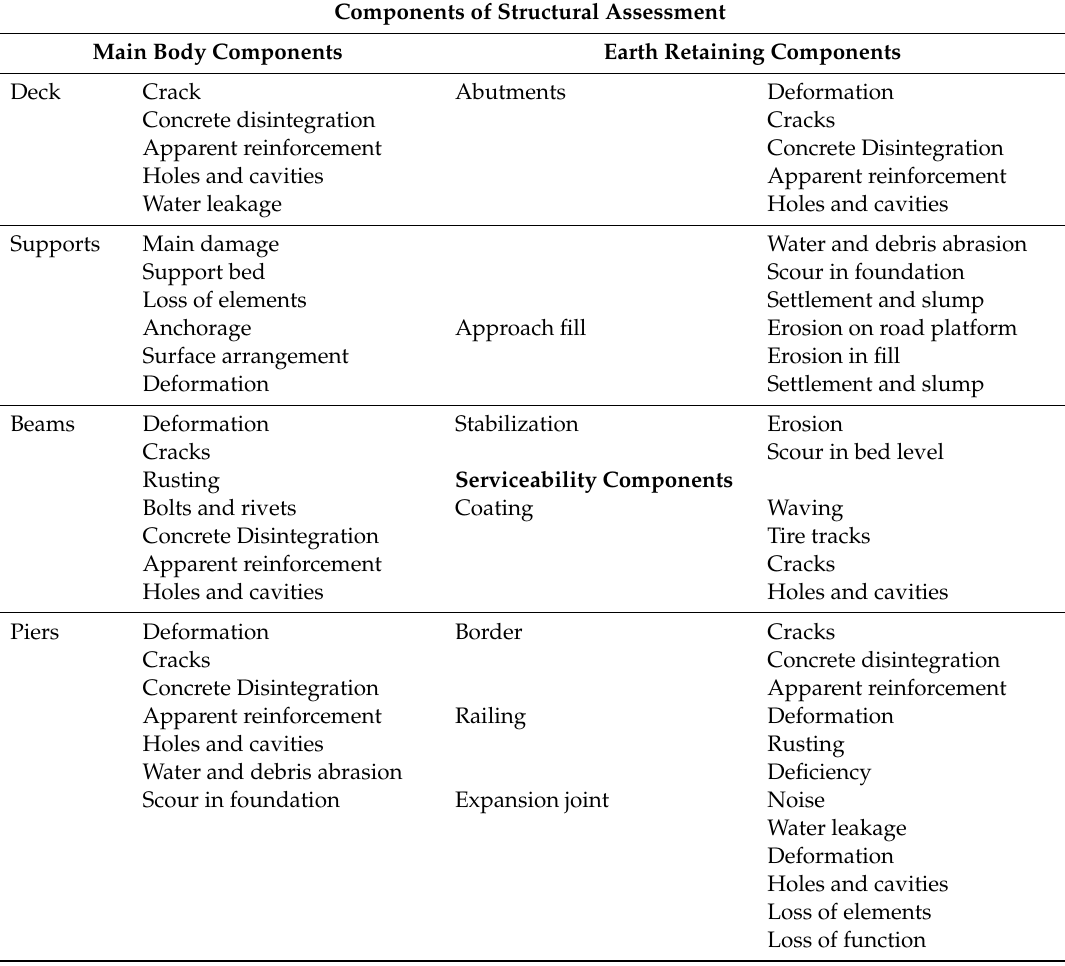
Table 8. Bridge characteristics.